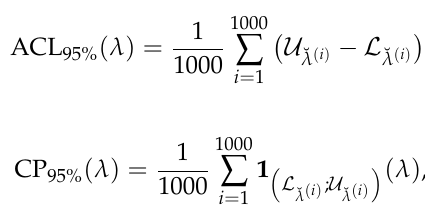
and respectively, where ˘ λ ( i ) is the calculated estimate at i th sample of λ . Additionally, taking τ = 5%, the comparison between the acquired interval estimates of λ is made based on their average confidence lengths (ACLs) and coverage percentages (CPs) as